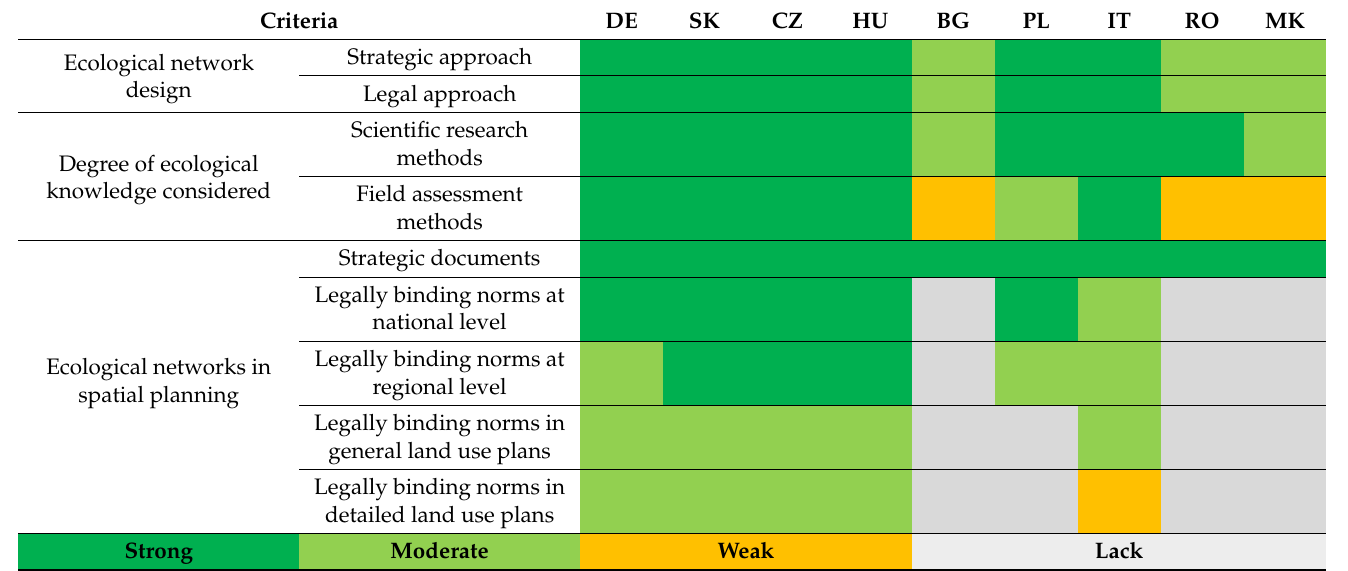
Table 1. The degree of implementation of ecological networks in the legislation of selected European countries. The degree is assessed on a decreasing scale from strong (dark green), moderate (light green), weak (yellow) down to the lack of implementation (gray) (Data source: [26]). Criteria DE SK CZ HU BG PL IT RO